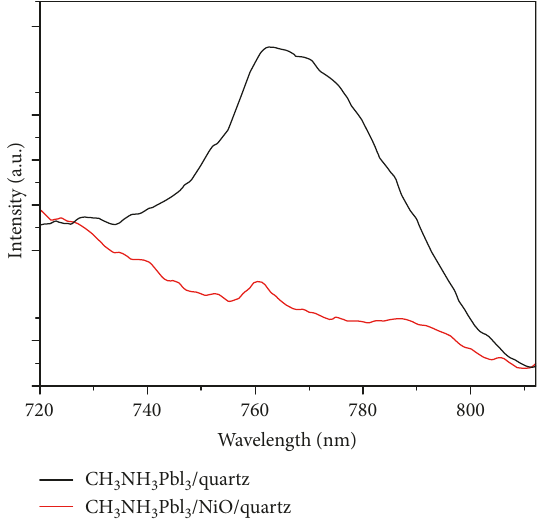
Figure 3: Photoluminescence spectra (excited by 600nm laser) of CH3NH3PbI3 fi lm deposited on top of NiO fi lm or quartz substrate. Reprinted with permission from